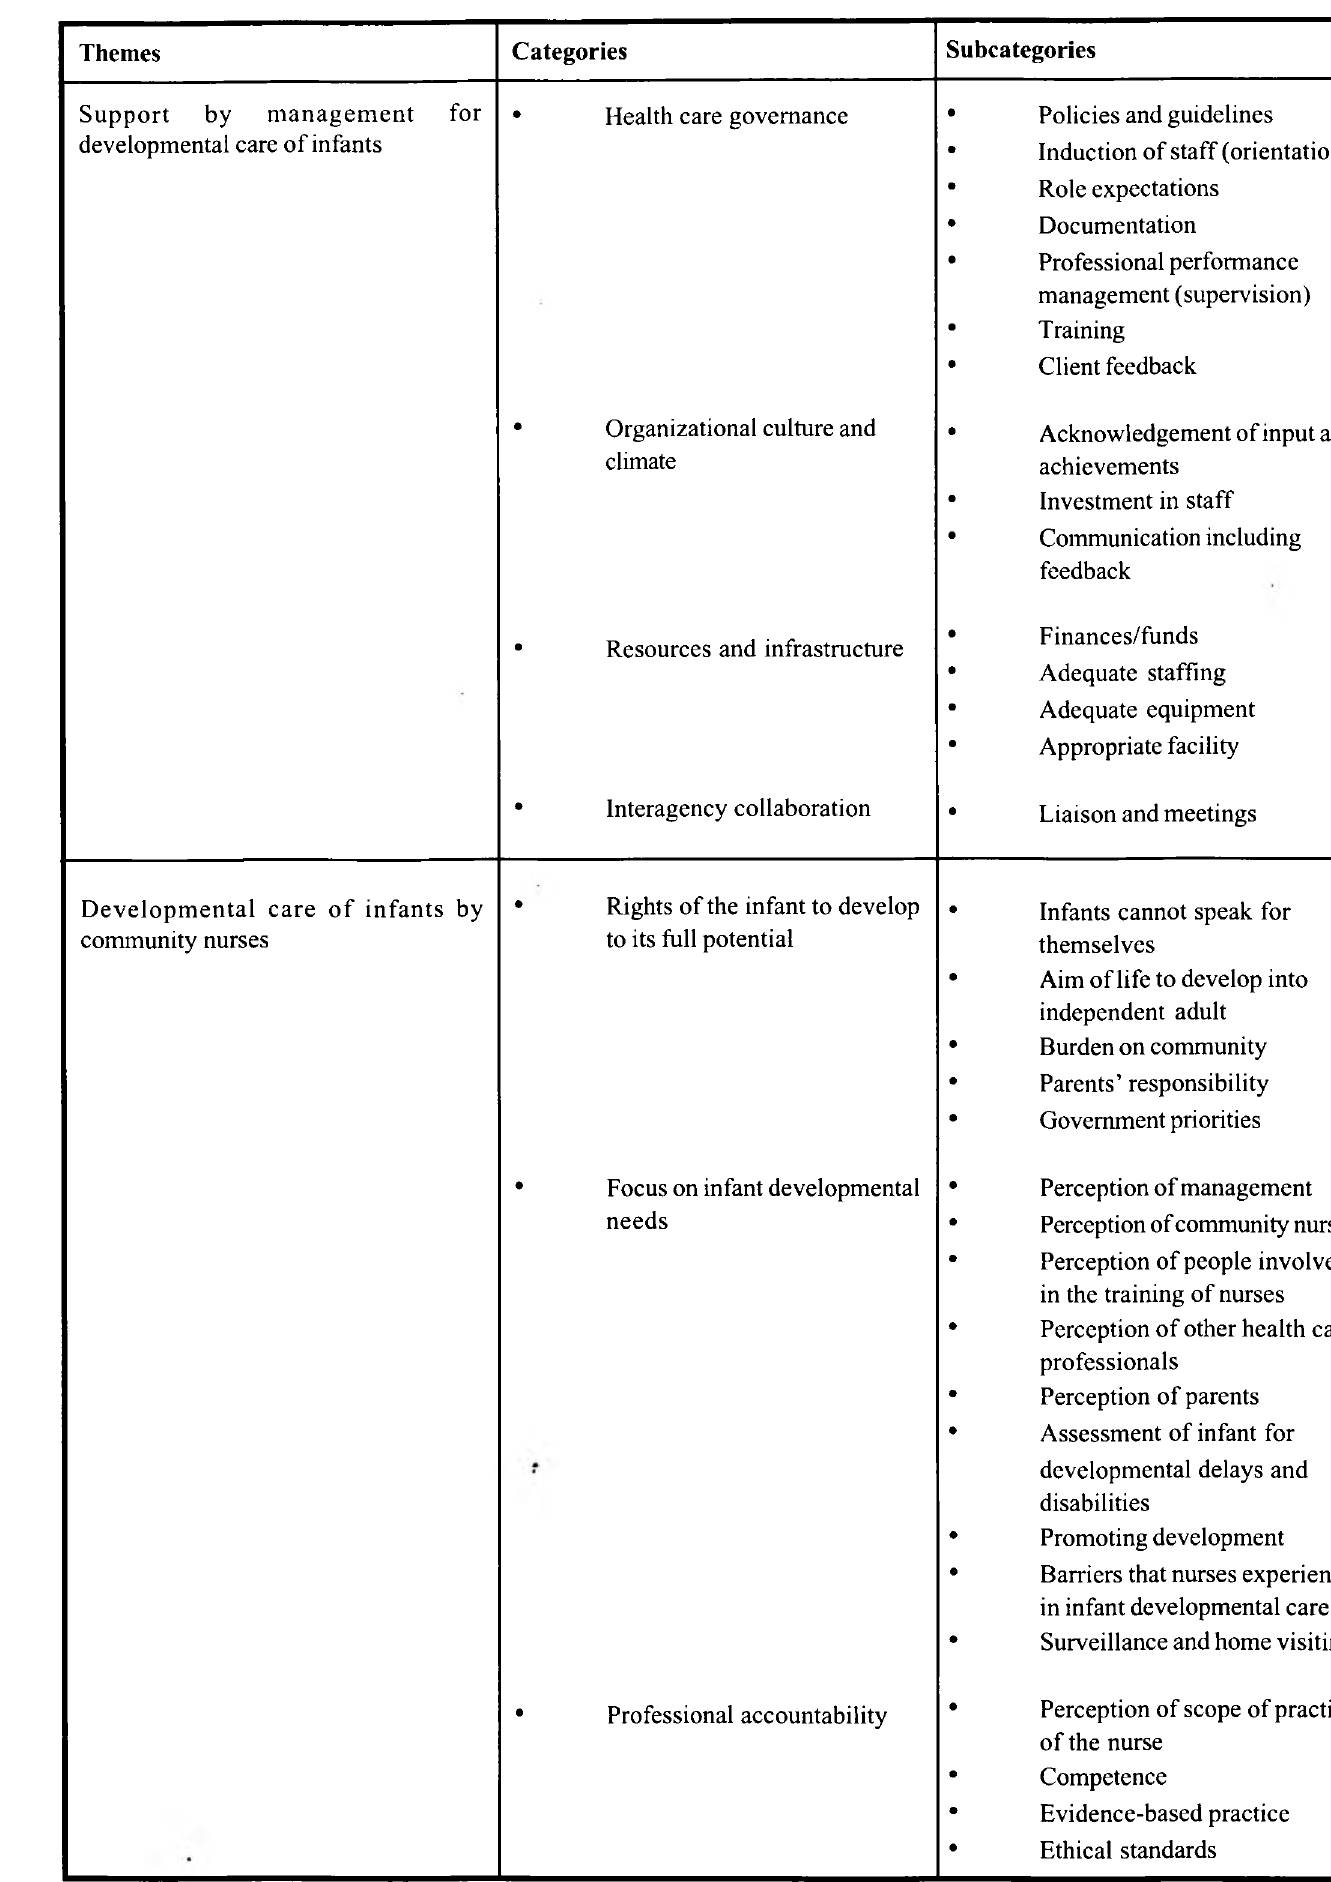
Table 1: Themes, categories and subcategories